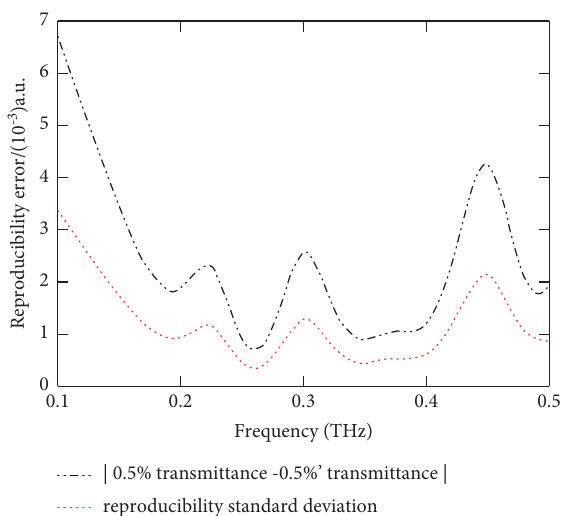
Figure 8: THz absorption coefficients of the CMC-Na colloid at different